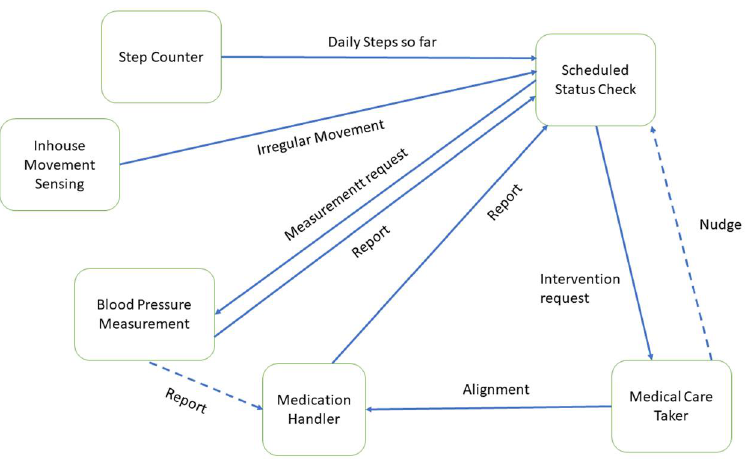
Figure 2. Capturing value streams for Design-integrated Engineering of Cyber-Physical Systems.